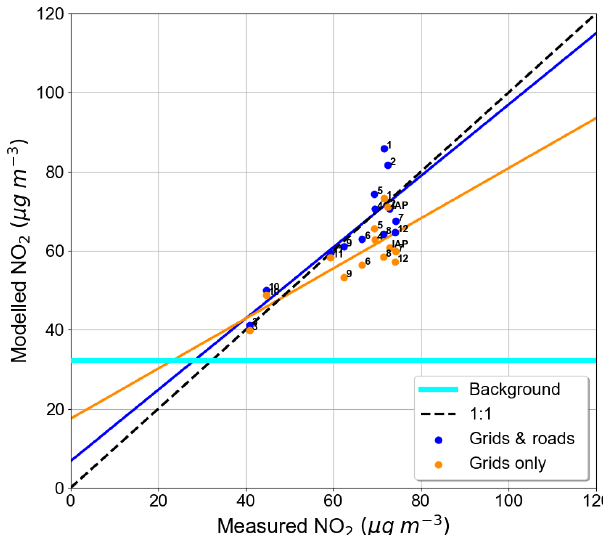
Figure 16. Campaign period measured and modelled NO 2 concen- trations at all the measurement sites (numbered). Modelled concen- trations produced using 3-D grid and explicit road emission sources (blue) and 3-D grid sources only (orange) derived from the MEIC Opt emissions inventory. Horizontal light blue line represents cam- paign period mean background NO 2 concentrations calculated from measurements.